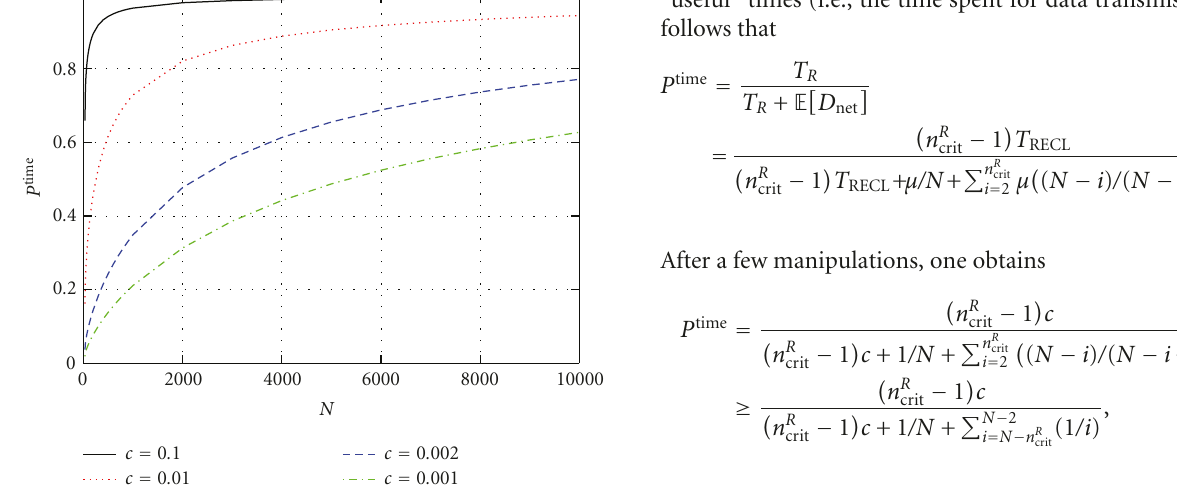
Figure 9: Time penalty, as a function of the number of sensors N , in a scenario with μ = 1aU. Four possible values of c are considered: (i) 0.1, (ii) 0.01, (iii) 0.002, and (iv)